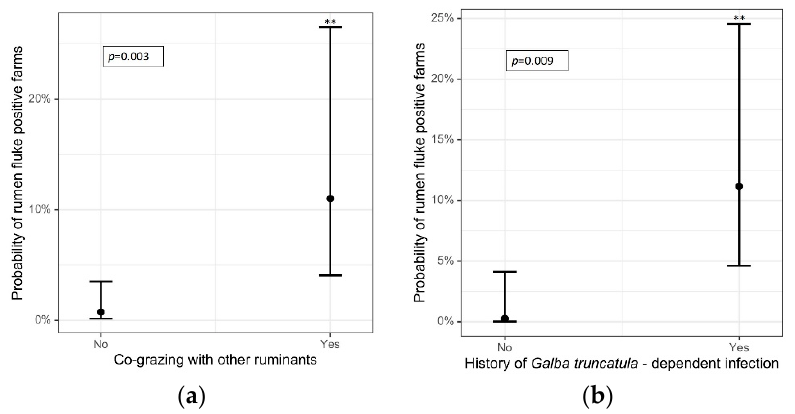
Figure 4. Predicted probabilities of patent rumen fluke infections in sheep in relation to ( a ) co-graz- ing with other ruminants ( p = 0.003) and ( b ) history of prior G. truncatula -dependent trematode in- fections on the farm ( p = 0.009). The error bars indicate the 95% confidence intervals. **: p -value < 0.01.